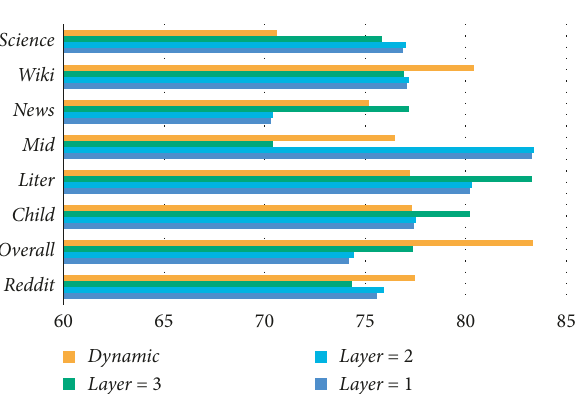
Figure 4: Feature extraction model structure.